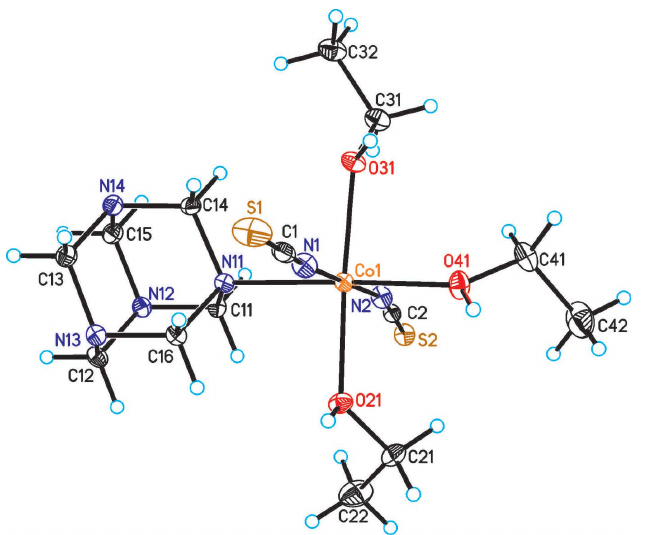
Figure 2 Crystal structure of compound 2 with labelling and displacement ellipsoids drawn at the 50% probability level.